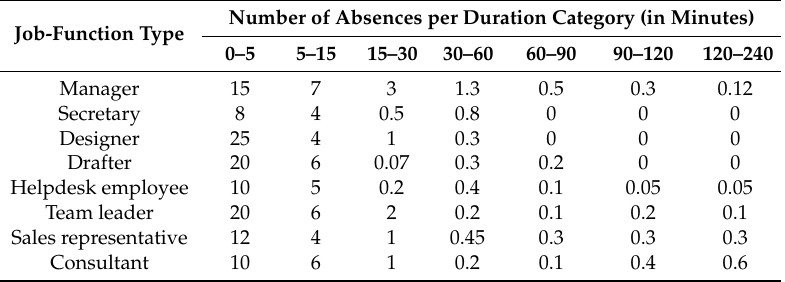
Table 2. Number of absences per duration category for the different job-function